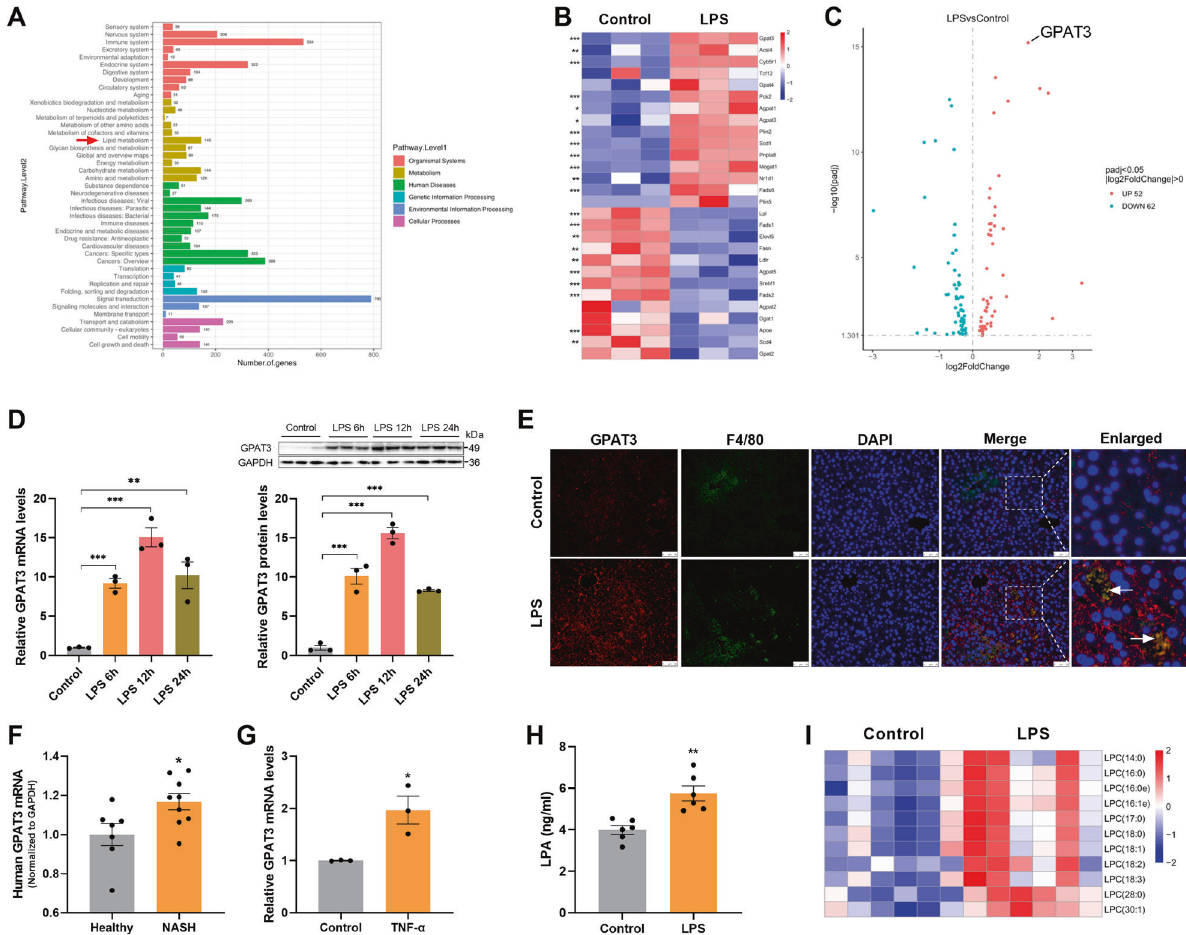
metabolism as the top-ranking affected metabolism pathway ( n = 3). B Heatmap showing the expression of lipid metabolism pathway genes, as measured using transcriptomics, in the normal and LPS-stimulated KCs ( n = 3). C Volcanic map showing the GPAT3 was the most signi fi cant difference among lipid metabolism genes after LPS stimulated KCs for 24 h ( n = 3). D qPCR and Western blot analysis of GPAT3 expression in normal and LPS (100 ng/ml)-stimulated KCs at different time points ( n = 3). E Immuno fl uorescence staining for GPAT3 expression in KCs